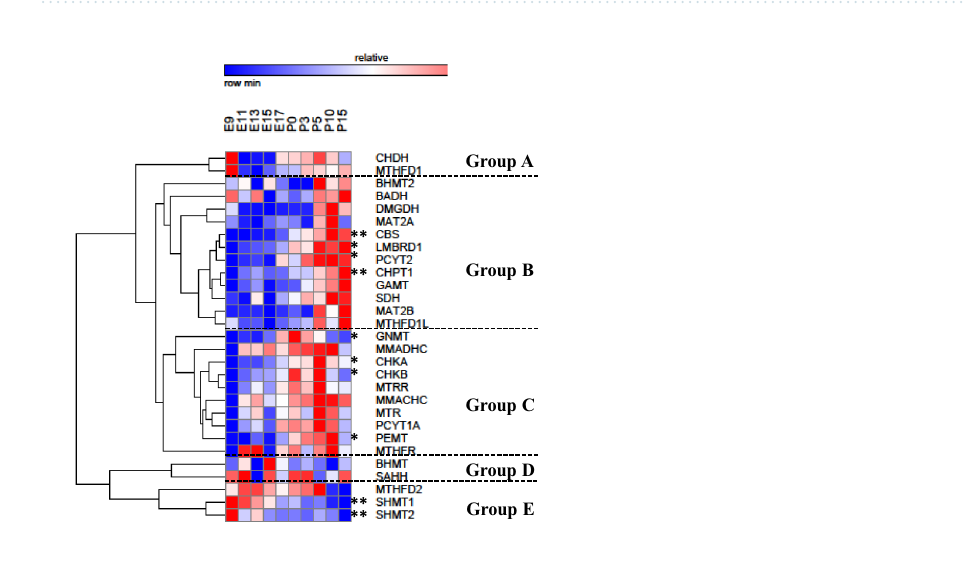
Figure 5. One-way hierarchical clustering of expression profiles for genes involved in 1C metabolism during brain ontogenesis. The left tree describes the relationship between different gene expression profiles. The dendrogram scale represents the correlation distances. Average expression values of three replicates per age are given by colored squares: red, relatively high expression; blue, relatively low expression. The dashed line categorizes the genes according to their expression profiles into five major groups. Stars represent the result of the Kruskall–Wallis test: *significant at the 0.05 level; **significant at the 0.01 level; ***significant at the 0.001